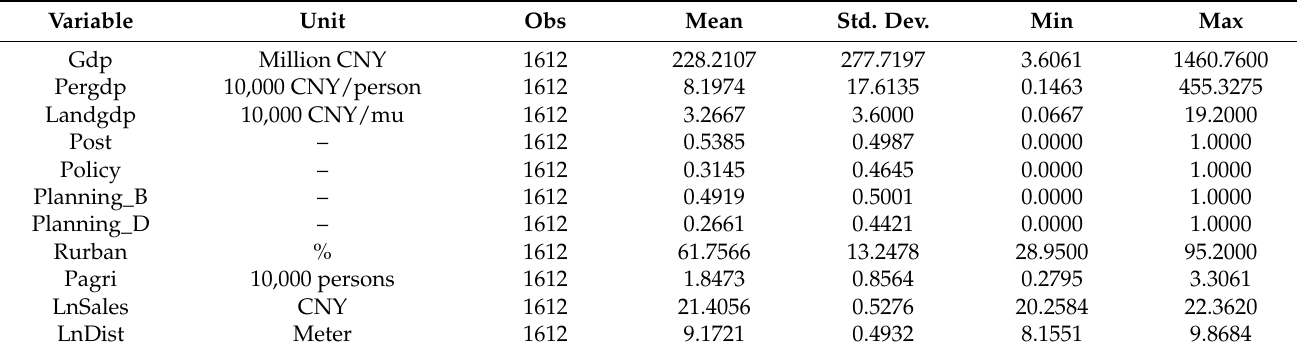
Table 2. Descriptive statistics of the main